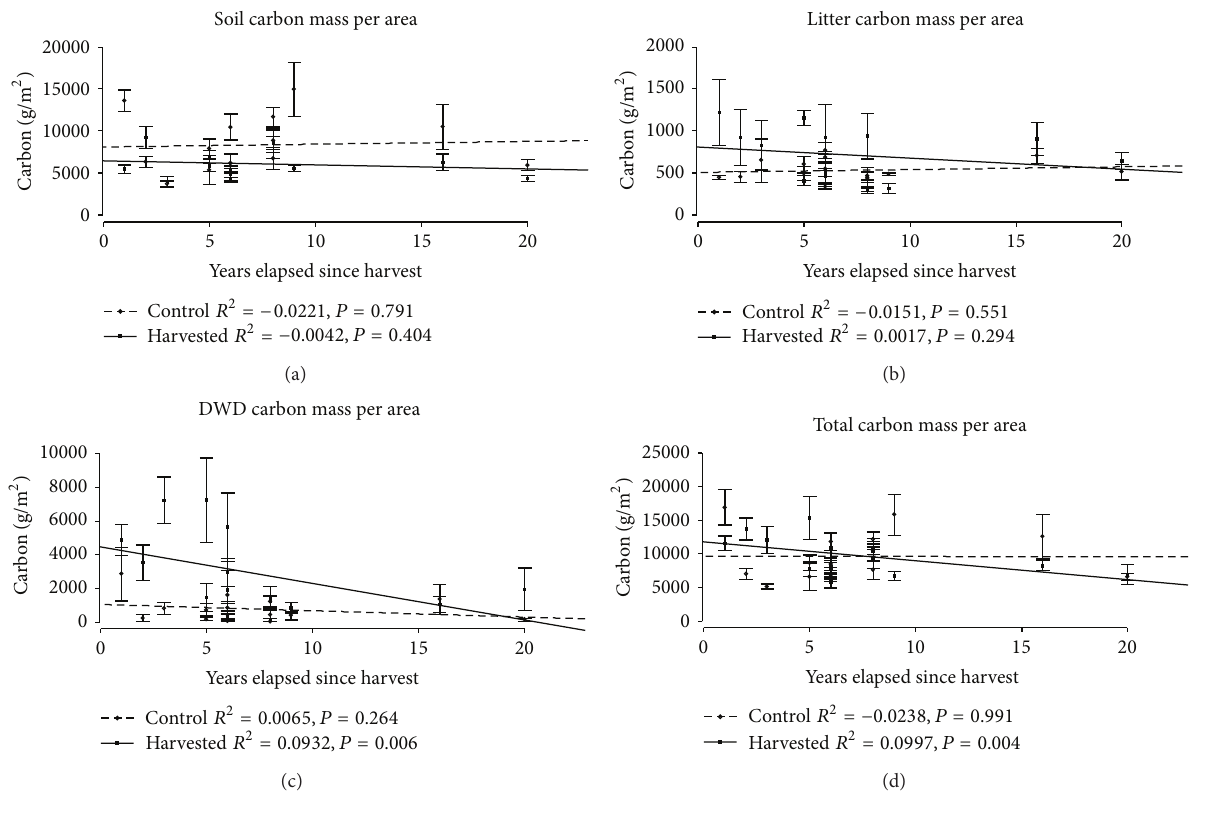
Figure 4: Regressions depicting mass per area change of each carbon pool over time for control and shelterwood harvested sites: (a) soil carbon change, (b) litter carbon change, (c) coarse woody debris carbon change, and (d) total carbon change for three combined